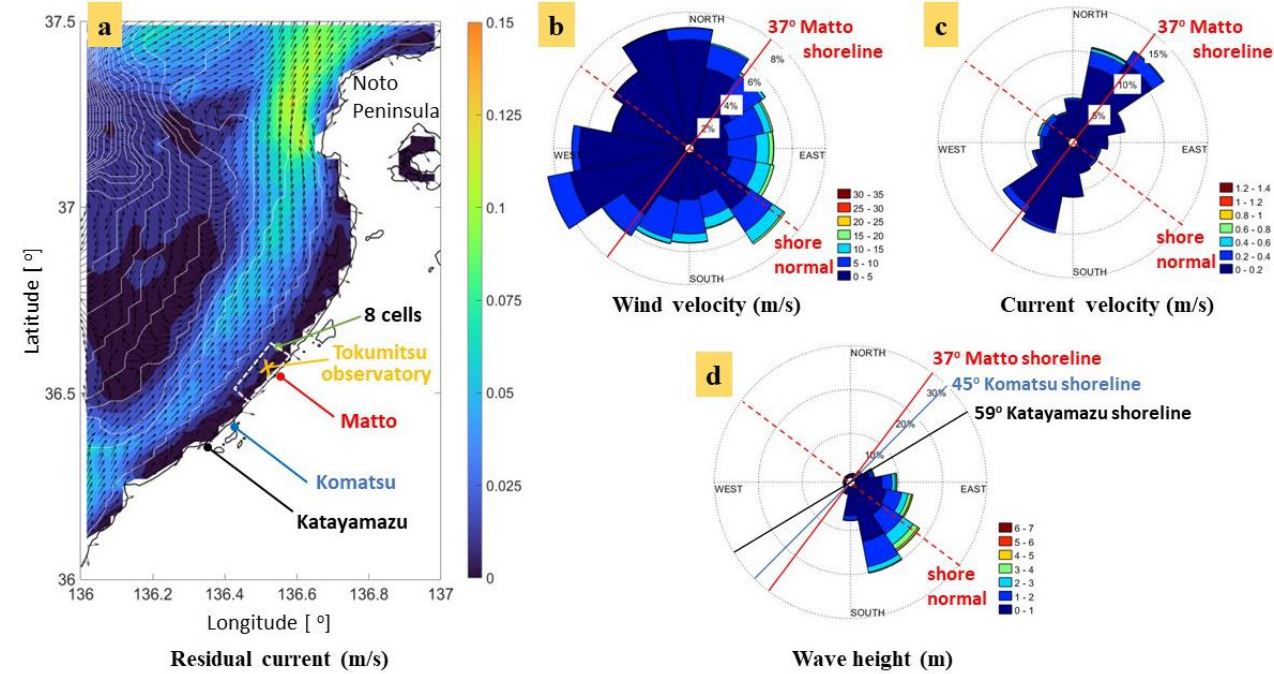
Figure 2. External forces on the littoral sediment cell (LC): ( a ) annual average velocity distribution in 2001 (m/s) and contours of 50-m intervals ( b ) wind velocity (m/s) ( c ) current velocity (m/s) ( d ) wave height (m) recorded at the Tokumitsu Observatory during 1996 – 2017.